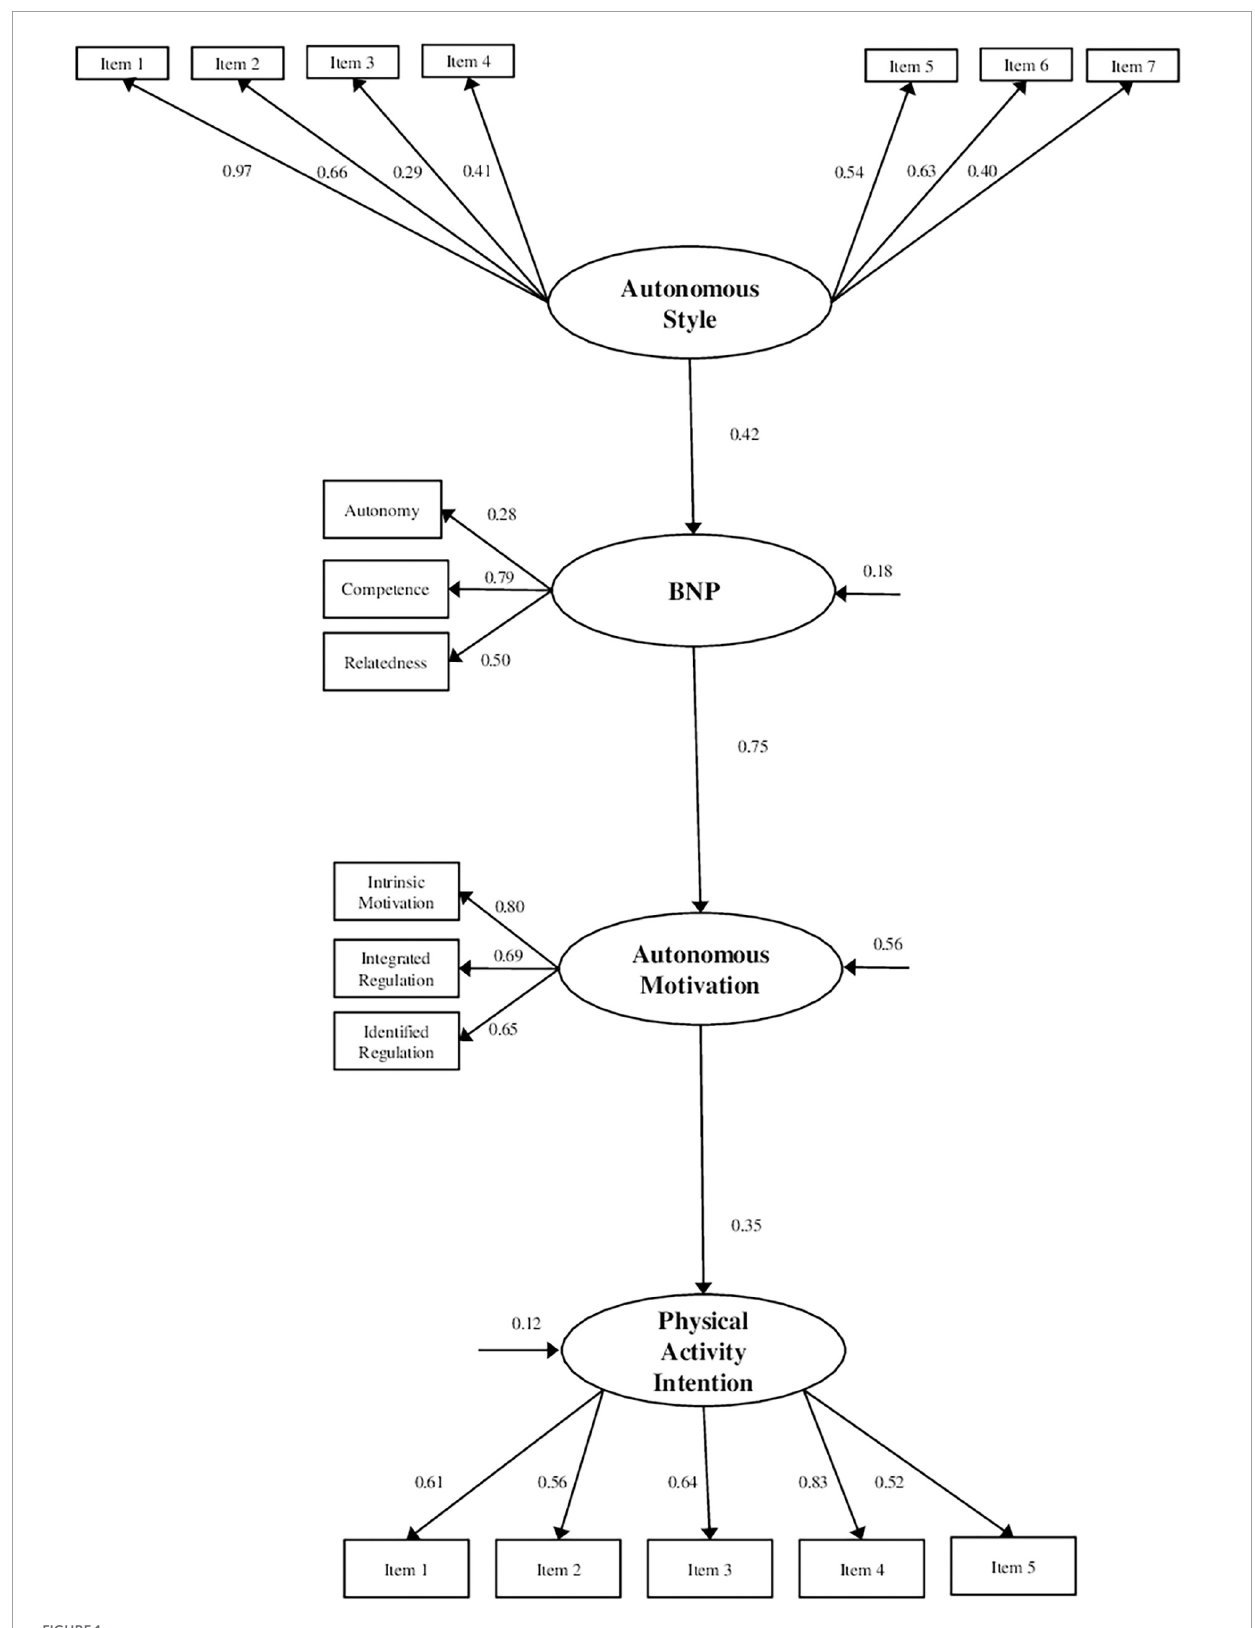
FIGURE1 Standardized solution of the structural model of autonomy support, autonomy satisfaction, relationship and competence, autonomous motivation, and the intention to be physically active. All parameters are standardized and significant at p < 0.05.